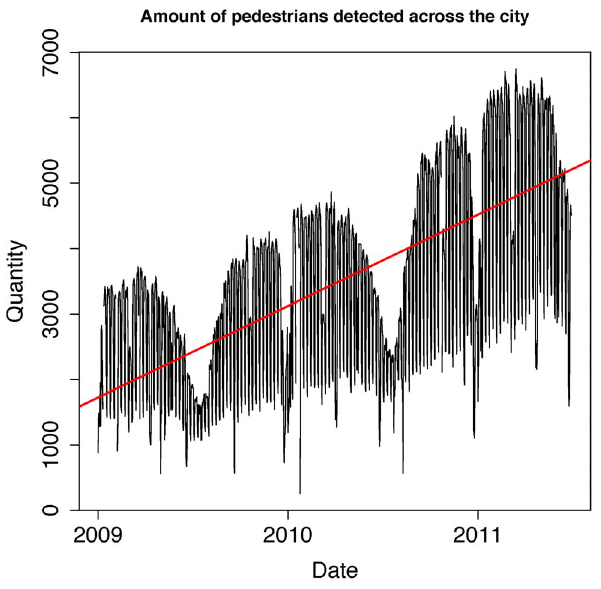
Figure 3. Total number of unique devices detected in the city during the study period. The data demonstrates how over a period of three years the volume of devices doubles, much unlike the population of our city that has grown at more modest